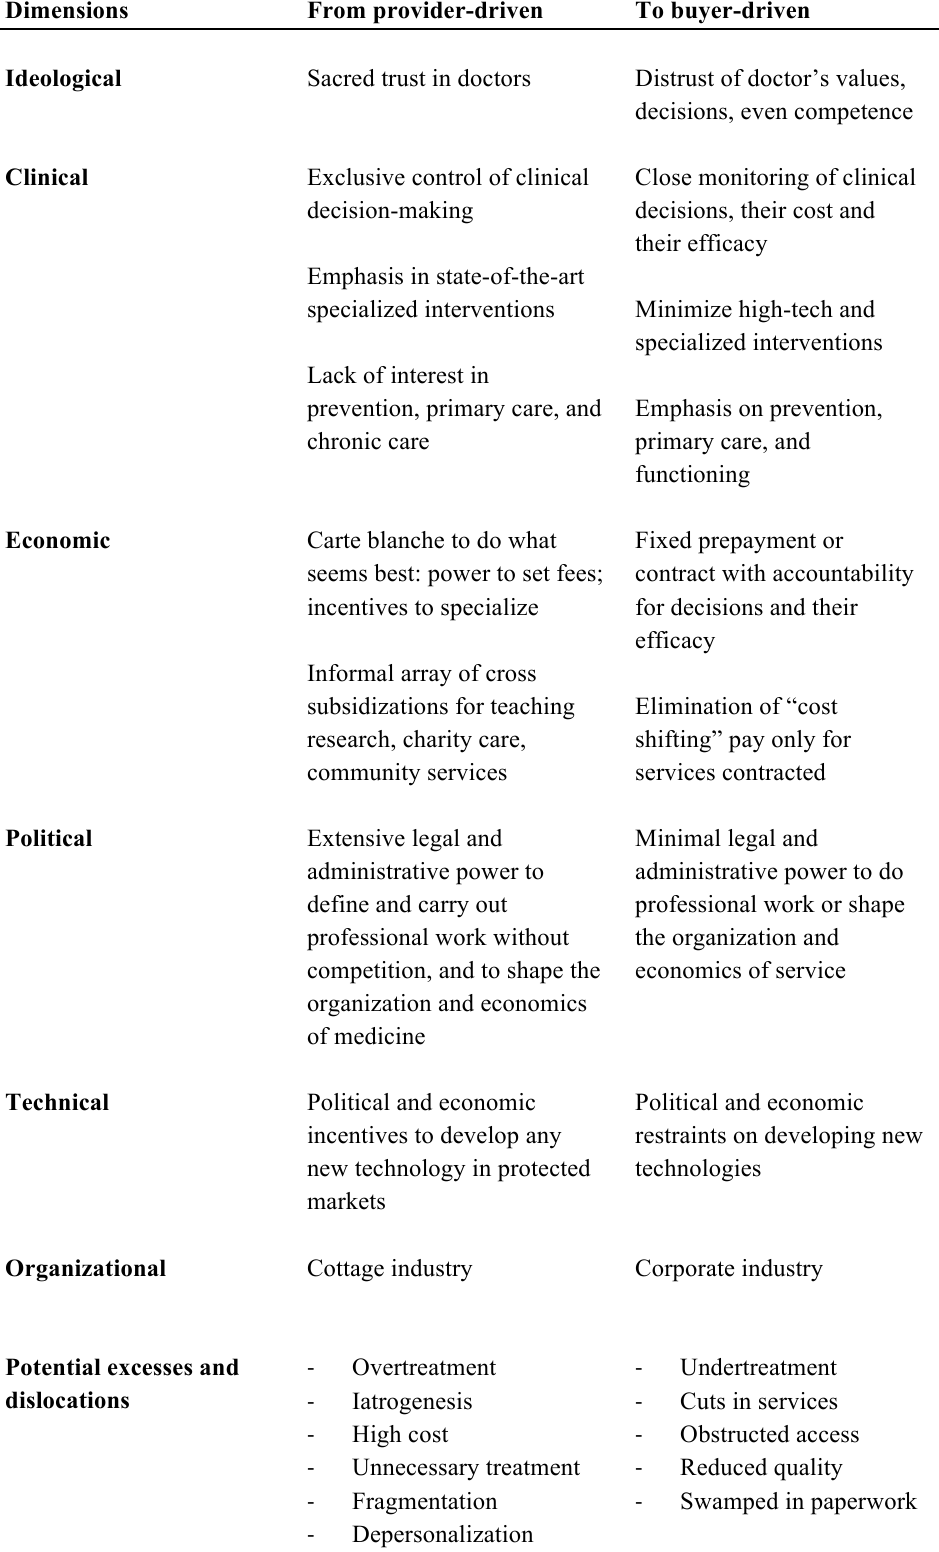
The Buyer’s Revolt against rising and various cocts by autonomous providers (Light,